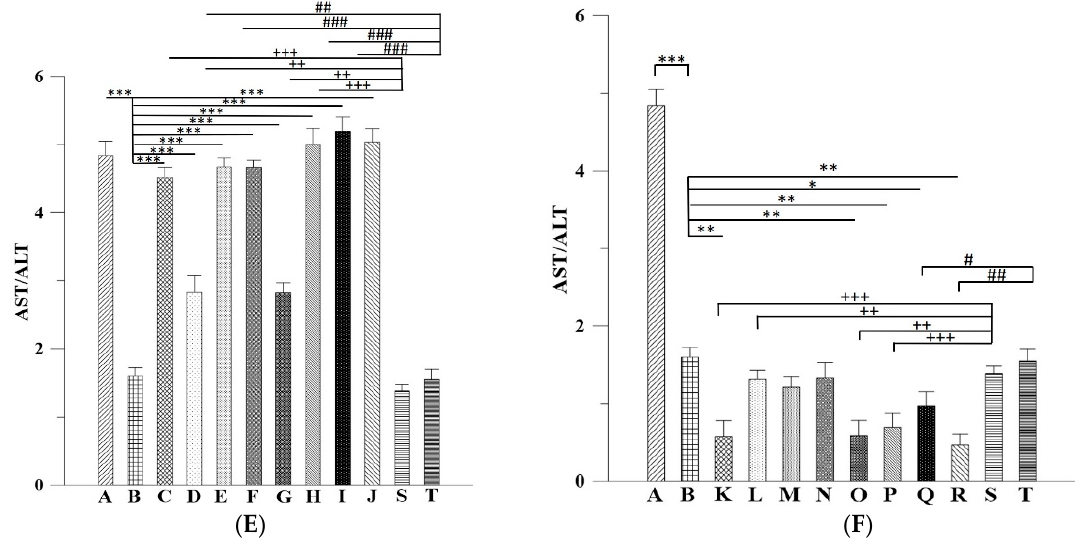
Figure 8. ALT, AST levels and the AST:ALT ratio of mice treated with Asta-lipo (subfigures A , B and E ) or pure liposomes (subfigures C , D and F ) for 2 and 4 weeks. Mice were given Asta-lipo or pure liposomes for 2 or 4 weeks prior to the 3-week 30% alcohol consumption (Groups C – F and K – N ) or 3-week 30% alcohol administration plus a second dose of 30% alcohol (Groups G – J and O – R ) as shown in Table 1. The letters A to T in each subfigure represent Groups A to Group T where the treatment conditions of each group are shown in Table 1 (Group A and the treated groups were compared to Group B ; Groups which received 2-week p.o and i.p. administration with Asta-lipo or pure liposomes were compared to Group S; Groups which received 4-week p.o and i.p. administration with Asta-lipo or pure liposomes were compared to Group T; N = 4, *,#,+ P < 0.05, **,##,++ P < 0.01 and ***,###,+++ P < 0.001, by ANOVA).